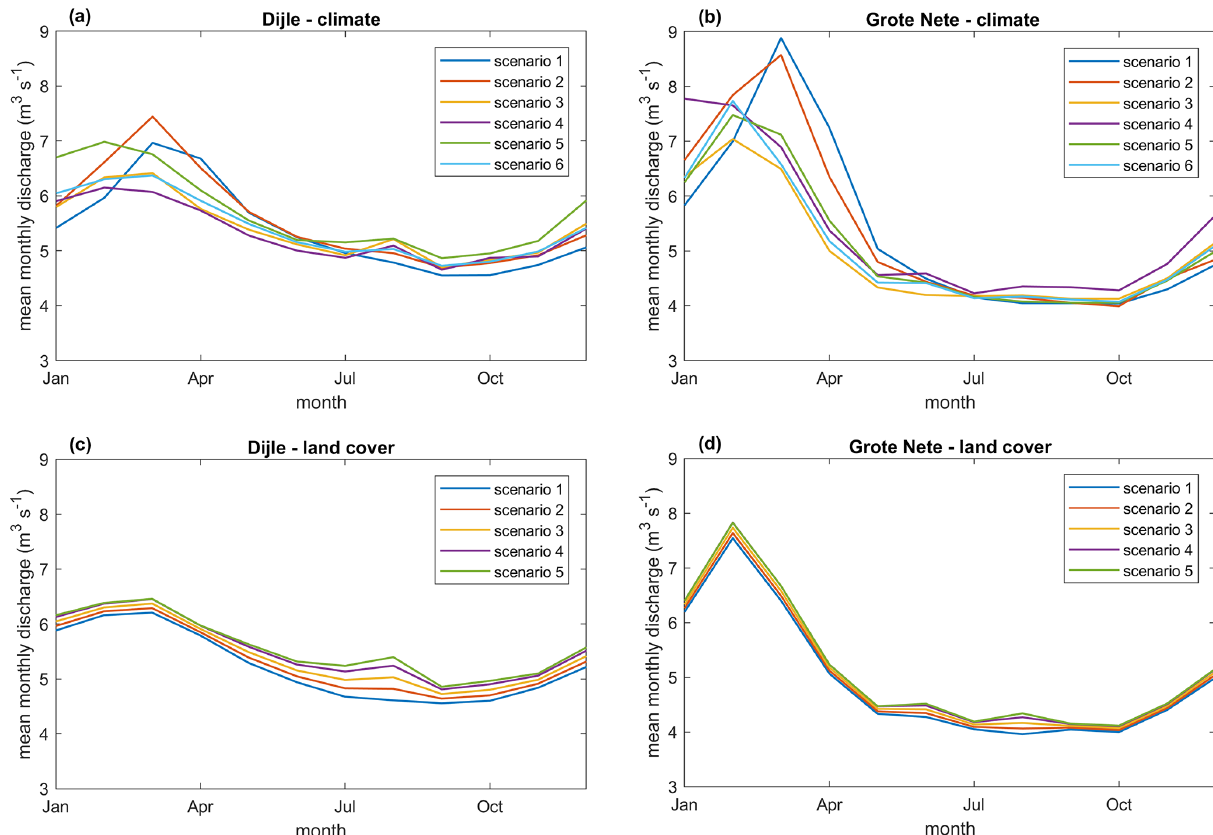
Figure A6. Simulated mean monthly discharge (m 3 s − 1 ) for the Dijle River at Korbeek-Dijle (a, c) and the Grote Nete River at Hulshout (b, d) under the different climate scenarios for land cover scenario 3 (a, b) and under the different land cover scenarios for climate scenario 6 (c, d)